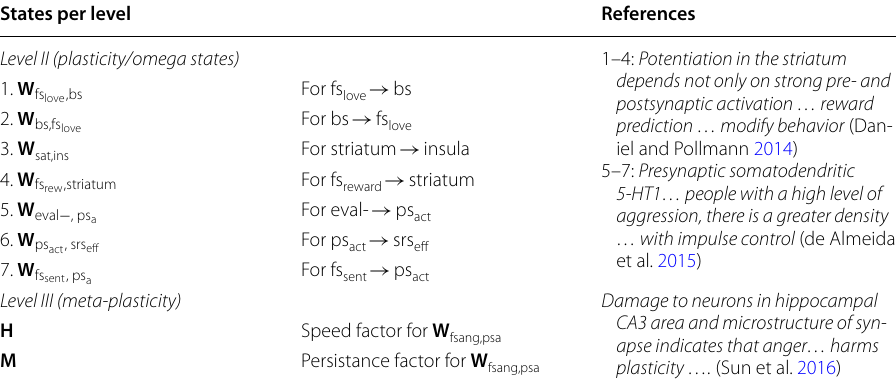
Table 2 Explanation of states in level II and III States per